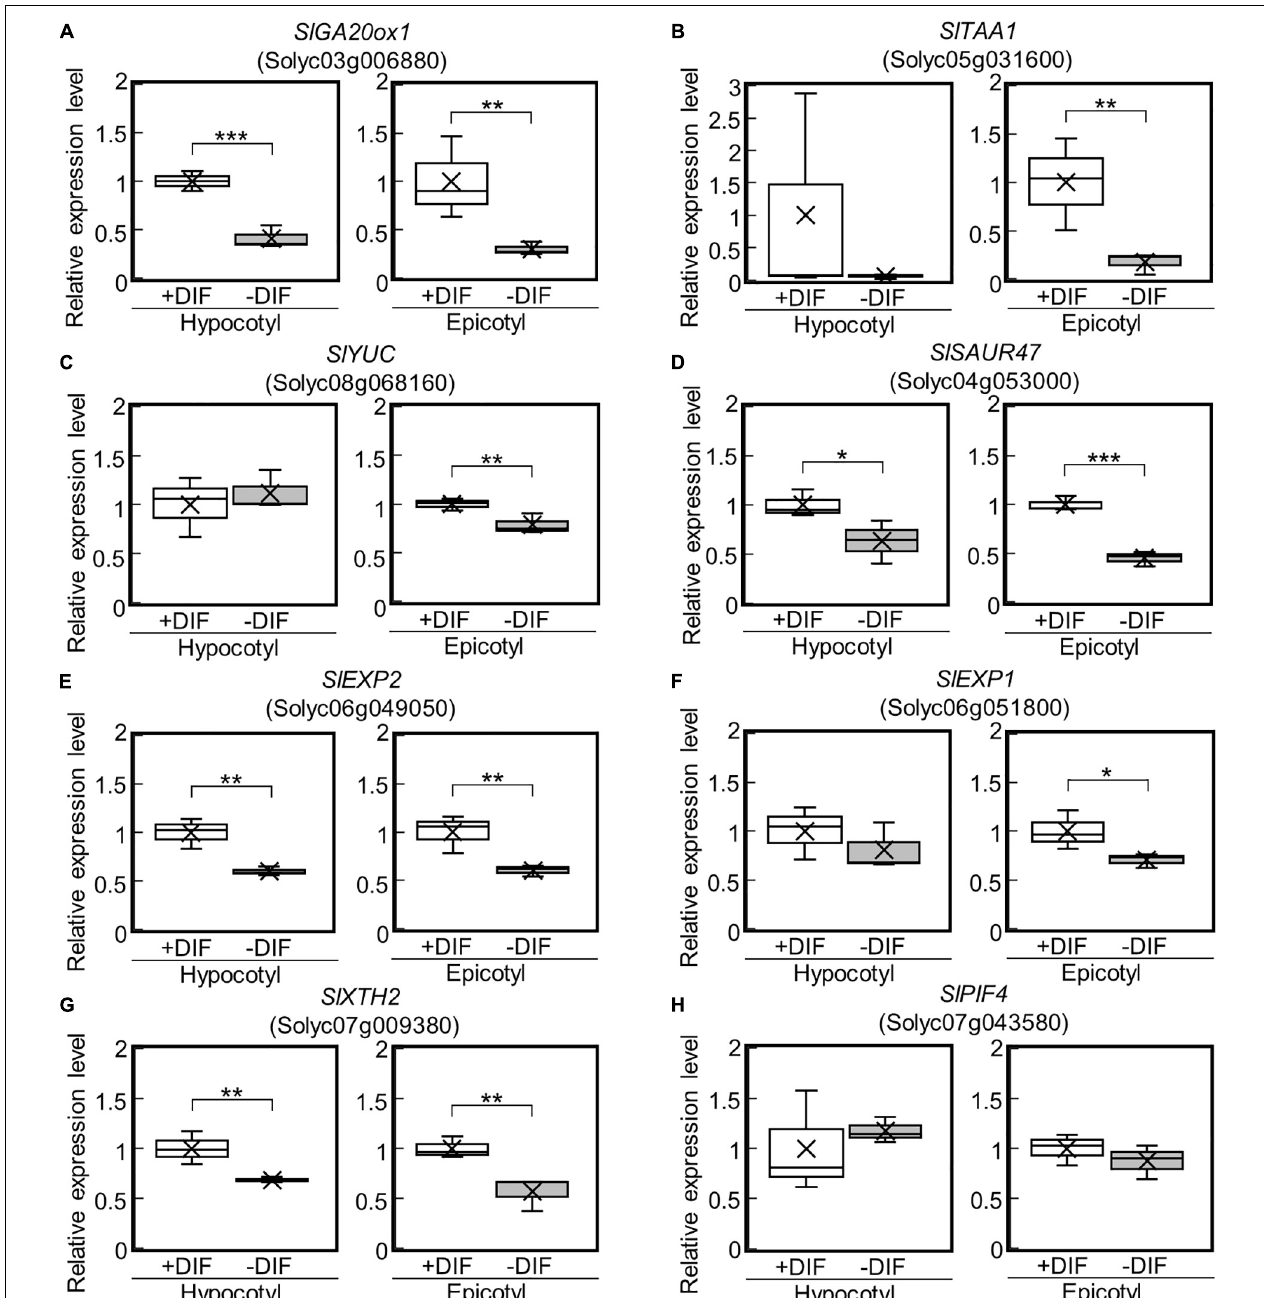
FIGURE 4 | Expression of GA-, IAA-, and cell wall-related genes in epicotyls and hypocotyls under negative and positive DIF treatments. The expression of SlGA20ox1 (A) , IAA-related genes ( SlTAA1 , SlYUC , SlSAUR47 ) (B–D) , cell wall-related genes ( SlEXP2 , SlEXP1 , SlXTH2 ) (E–G) , and SlPIF4 (H) in epicotyls and hypocotyls grown under positive and negative DIF treatments were analyzed using reverse transcriptase real-time PCR. Data are shown as boxplots ( n = 3). Cross marks in boxplot indicate the mean values. * P < 0.1; ** P < 0.05; *** P < 0.01 (Student’s t test). +DIF, positive DIF; -DIF, negative